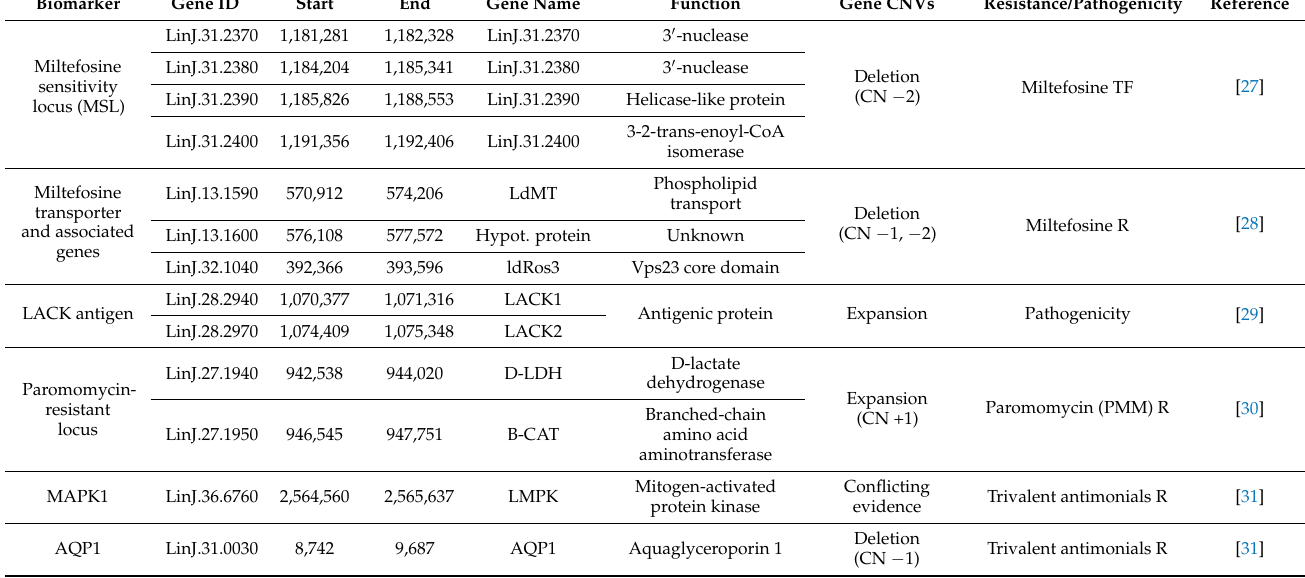
Table 2. Summary of known biomarkers for drug resistance in L. infantum . Summary of locus, gene ID, function, and reported gene copy number variation of the nine genomic regions (22 loci) analyzed related to pathogenicity or drug resistance in L. infantum . Gene ID, Start, and End correspond to the L. infantum reference genome ( L. infantum JPCM5 v2/2018) [18]. CNV: Expansion or deletion of gene copy number. R: Resistant; TF: Treatment failure. A reference is provided for studies showing threshold resistance effect by